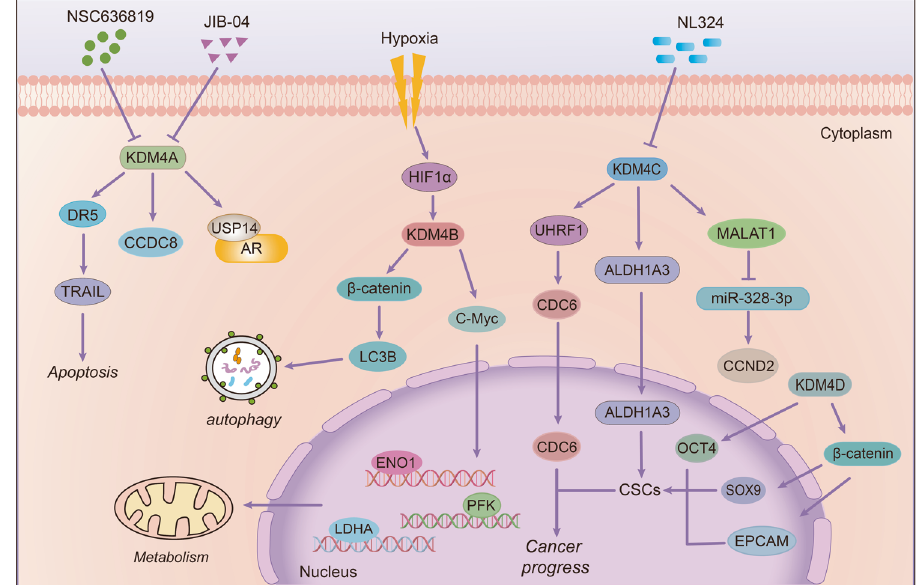
Fig. 10 The role of KDM4 family in drug resistance. Small-molecule inhibitors NSC636819 and JIB-04 inhibit KDM4A activity and increase cell sensitivity by affecting CCDC8 expression and apoptosis. Under hypoxia, KDM4B can induce autophagy and increase metabolism through activating the Wnt/ β -catenin pathway and transcribing C-Myc respectively. At the same time, KDM4C is able to promote cancer progress by in fl uencing cell cycle and transcription of CDC6, and KDM4D can increase the CSC property through the Wnt/ β -catenin and Notch signaling